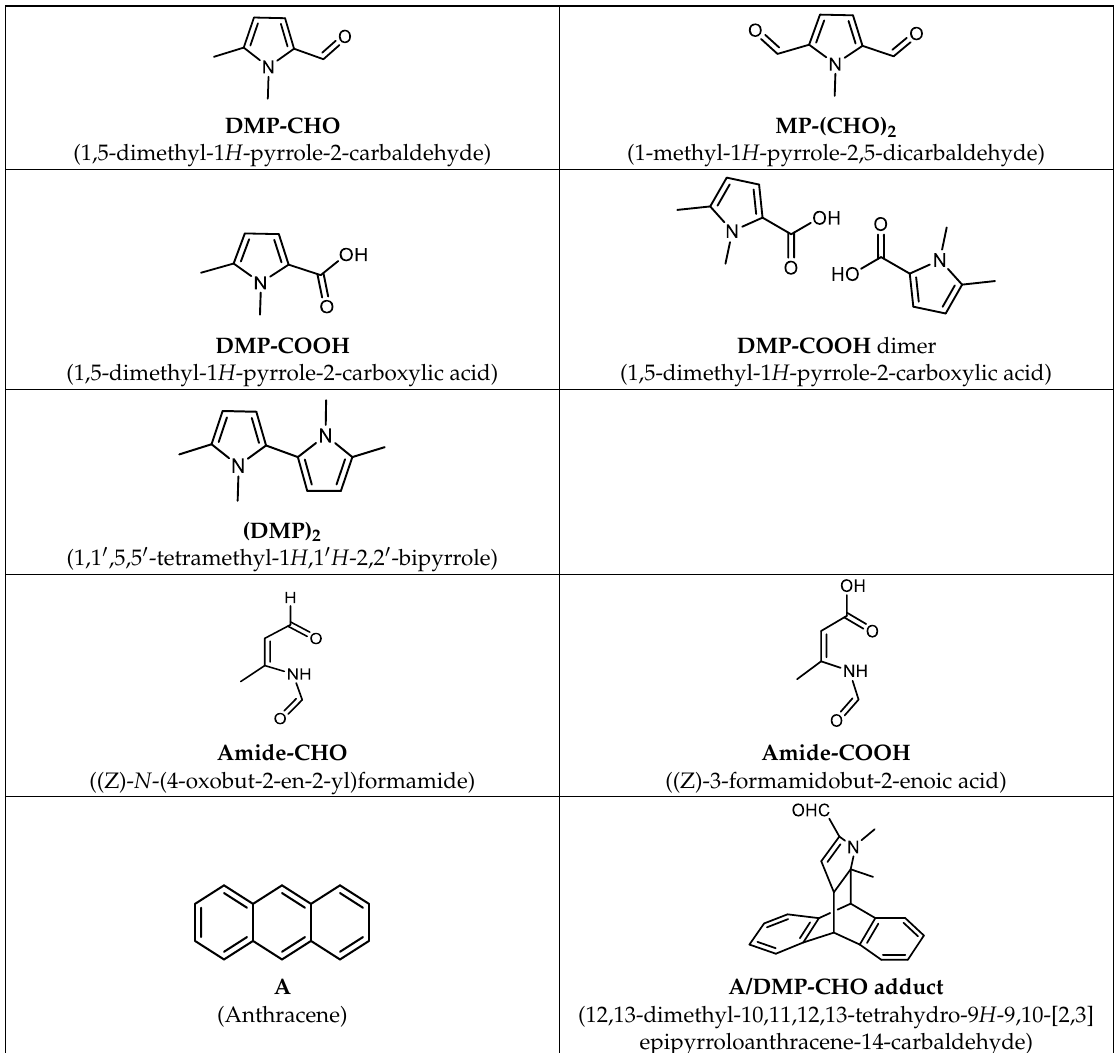
Table 2. Structures of model molecules (and complexes) selected for DFT spectra prediction.